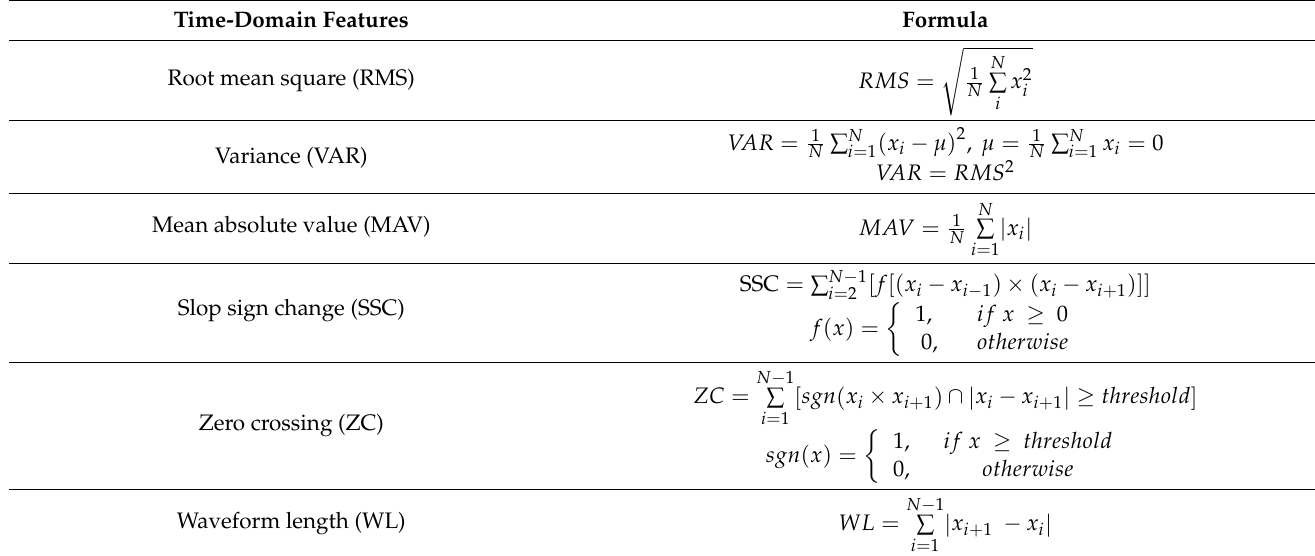
Table 1. Equations of the time-domain features used in this